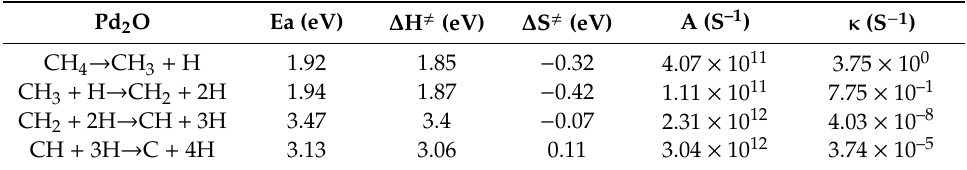
Table 3. The activation energy (Ea), di ff erence enthalpy between the transition state and the initial state ( ∆ H (cid:44) ), di ff erence entropies between the transition state and the initial state ( ∆ S (cid:44) ), pre-exponential factor (A), rate constant ( κ ) for methane activation on Pd 2 O. Pd 2 O Ea